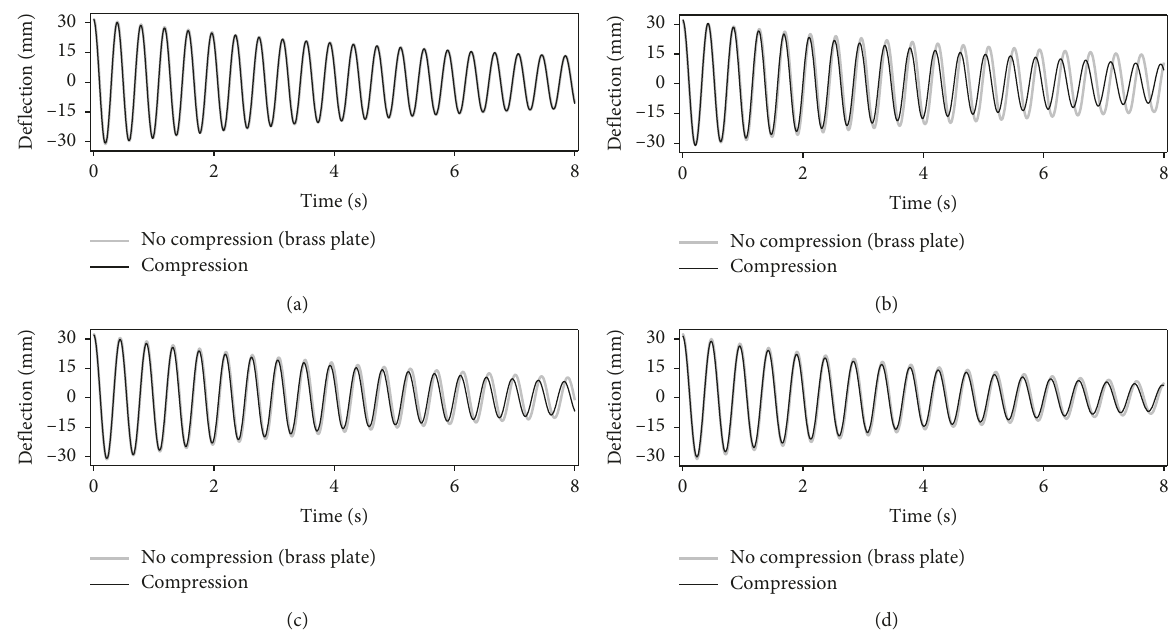
Figure 14: The effect of squeezing of the damping element MRE 1A: (a) no magnets, (b) magnets M5, (c) magnets M8, and (d) magnets